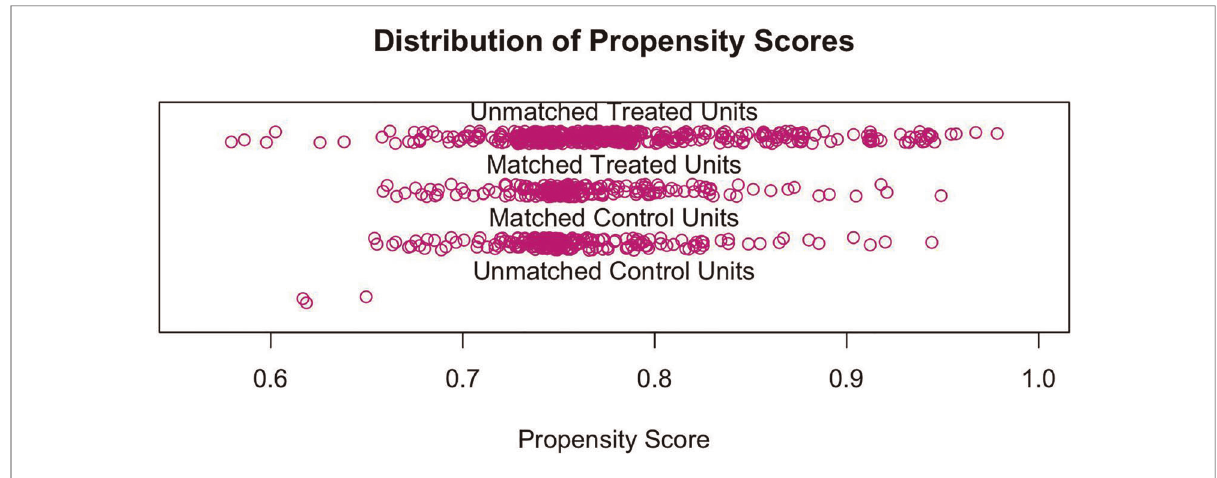
FIGURE 1 Matching jitter chart of bias scores between Beapenem group and Meropenem